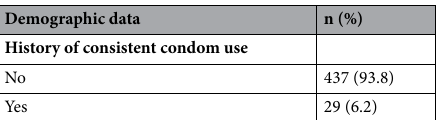
Table 1. Baseline characteristics of participants (N = 2465). a No occupation was defined by the medical record reported that the participants have no occupation.